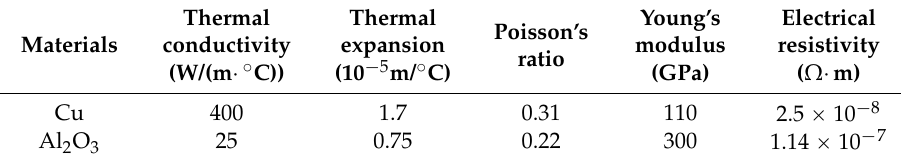
Table 2. Properties of other materials